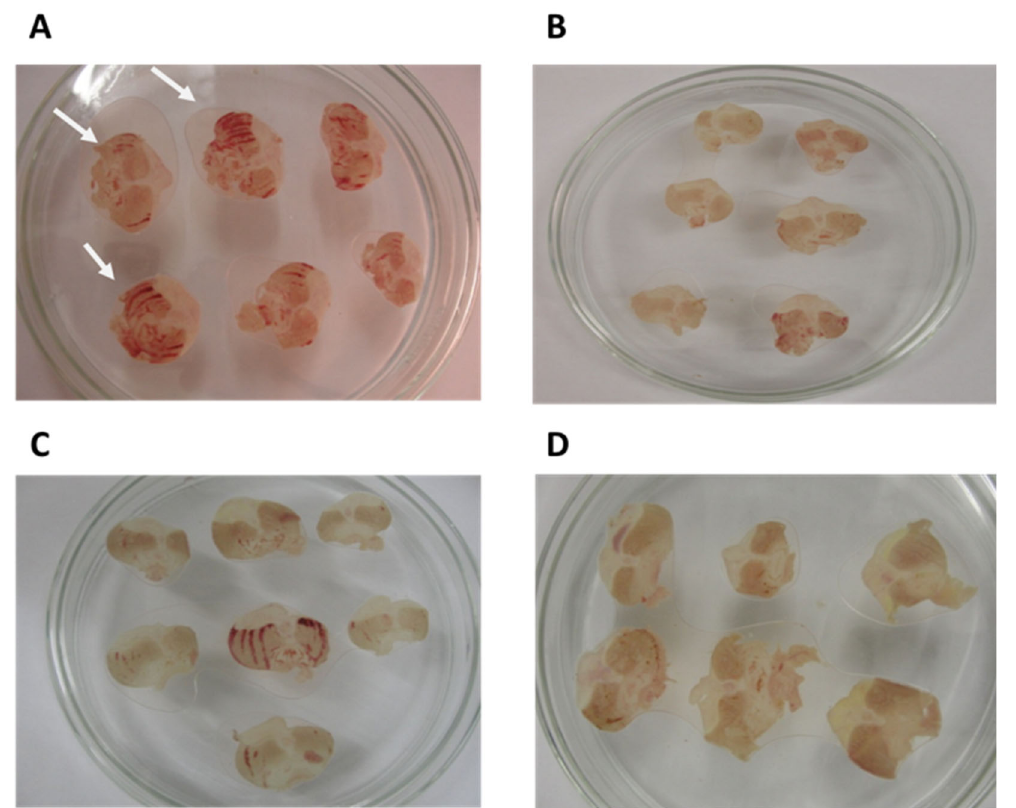
Figure 6. Injury area of the gastric mucosa of the stomachs in mice. ( A ) Negative control treated with saline, ( B ) BSHE administered in the proportion of 100 mg/kg, ( C ) BSHE: β -CD inclusion complexes in the proportion of 100 mg/kg, ( D ) positive control: carbenoxolone (100 mg/kg). (The white arrows signal the stretches).